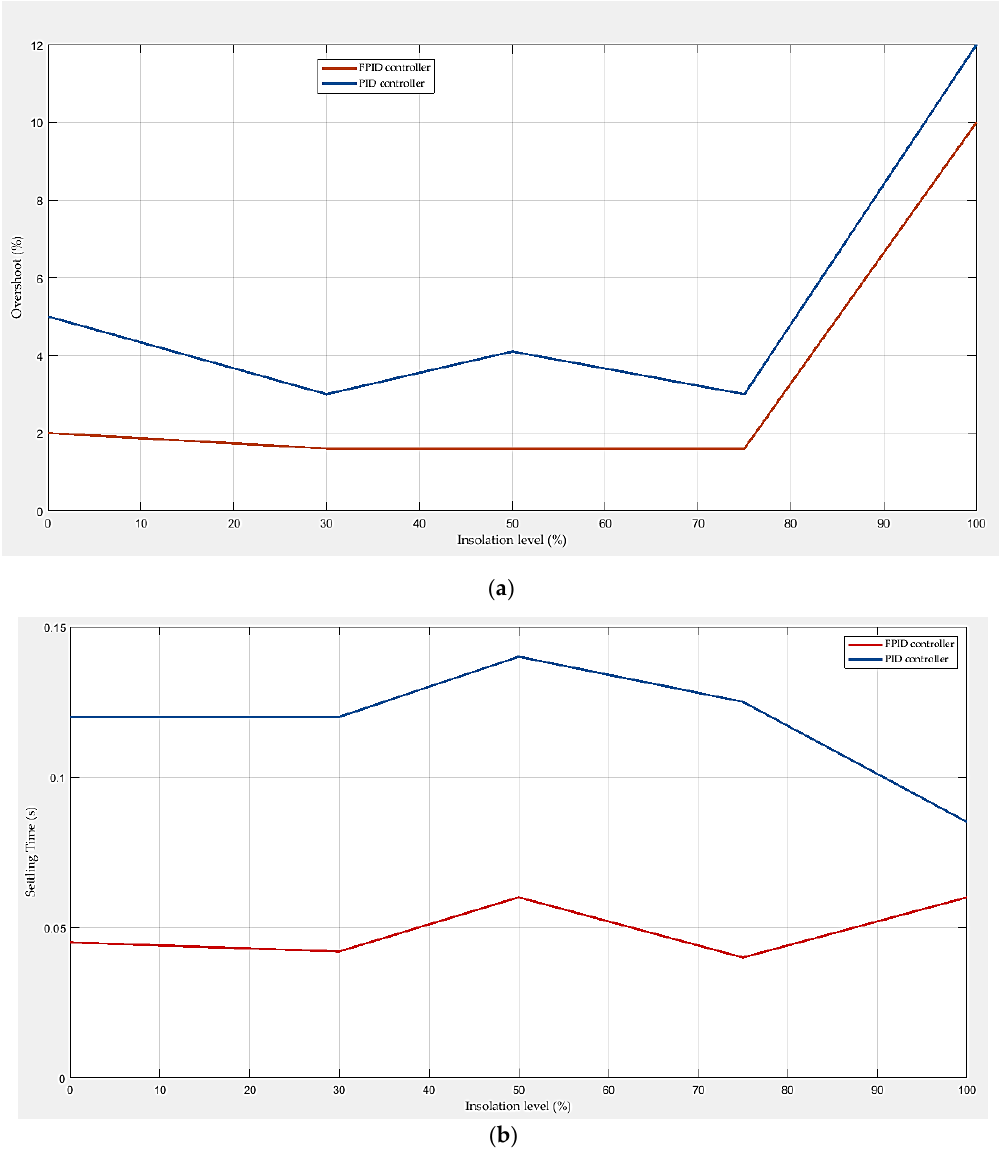
Figure 10. Comparison of the system response for FPID and PI controllers: ( a ) the overshoot, and ( b ) the settling time.